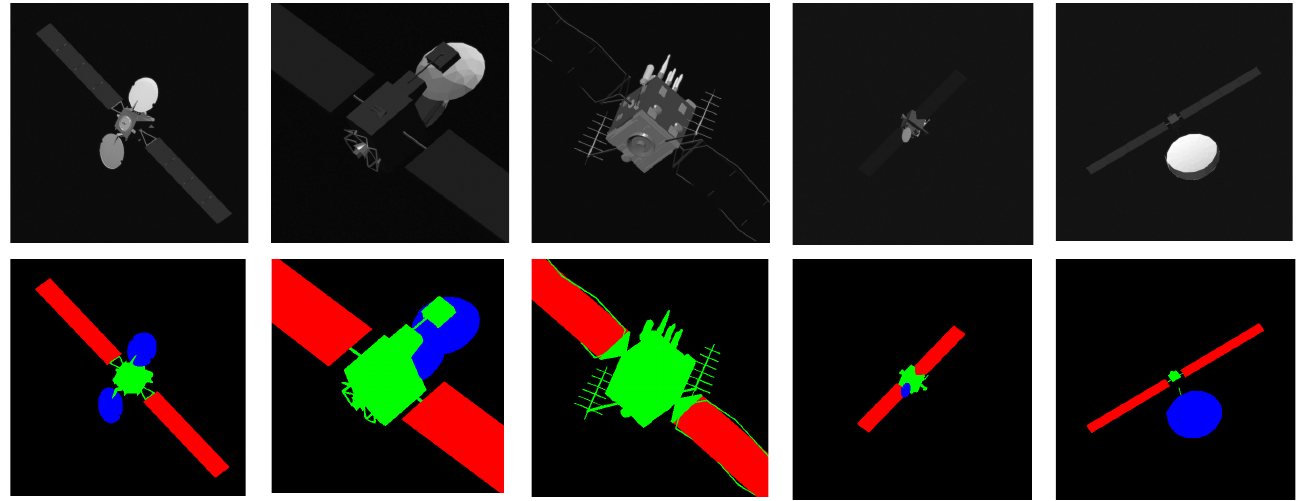
Figure 4. Examples of images and labels in the dataset. Red: solar panels; blue: antennae; green: